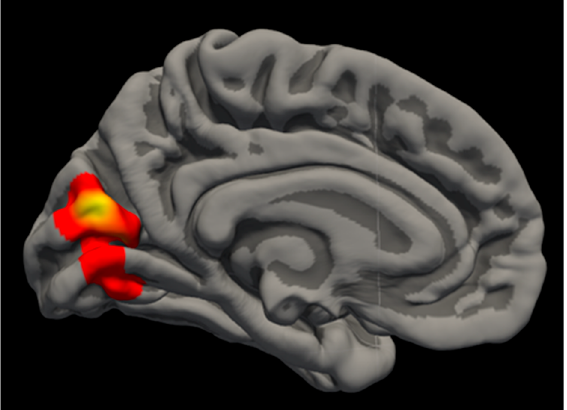
Figure 1. Cannabis Findings. Medial view of cannabis finding within left cuneus SA, with larger area in cannabis users.